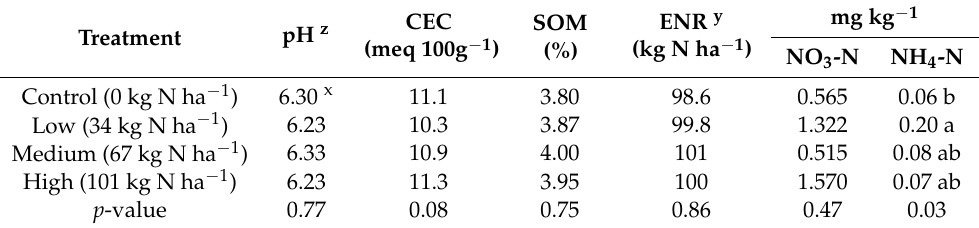
Table 5. Soil pH, cation exchange capacity (CEC), organic matter (SOM), estimated nitrogen release (ENR), and mineral nitrogen (NO 3 -N and NH 4 -N) of “Meeker” floricane red raspberry field fertilized with different nitrogen (N) fertilizer rates,